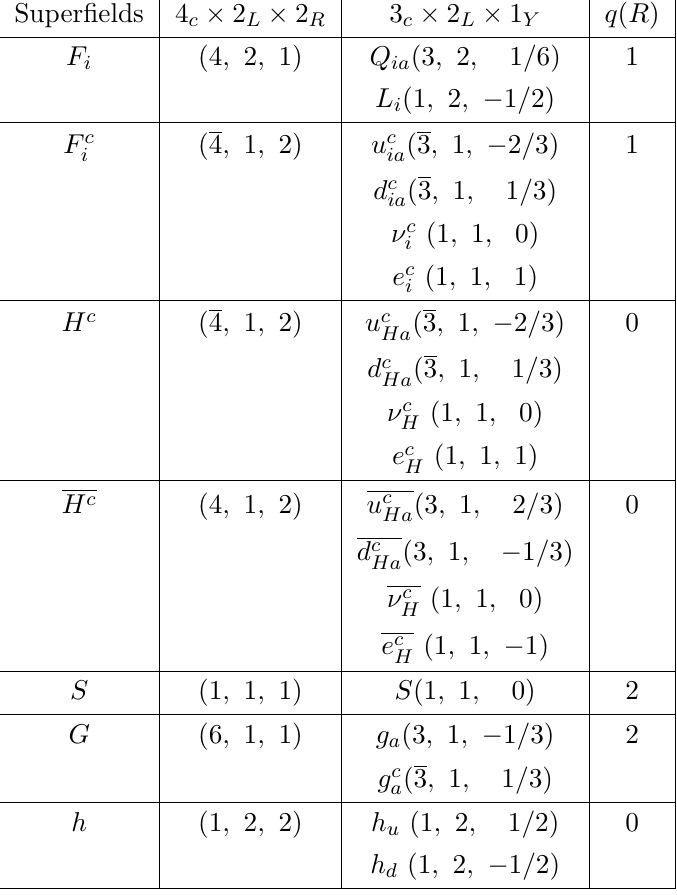
Table 1. Field content together with their decomposition under the SM and R